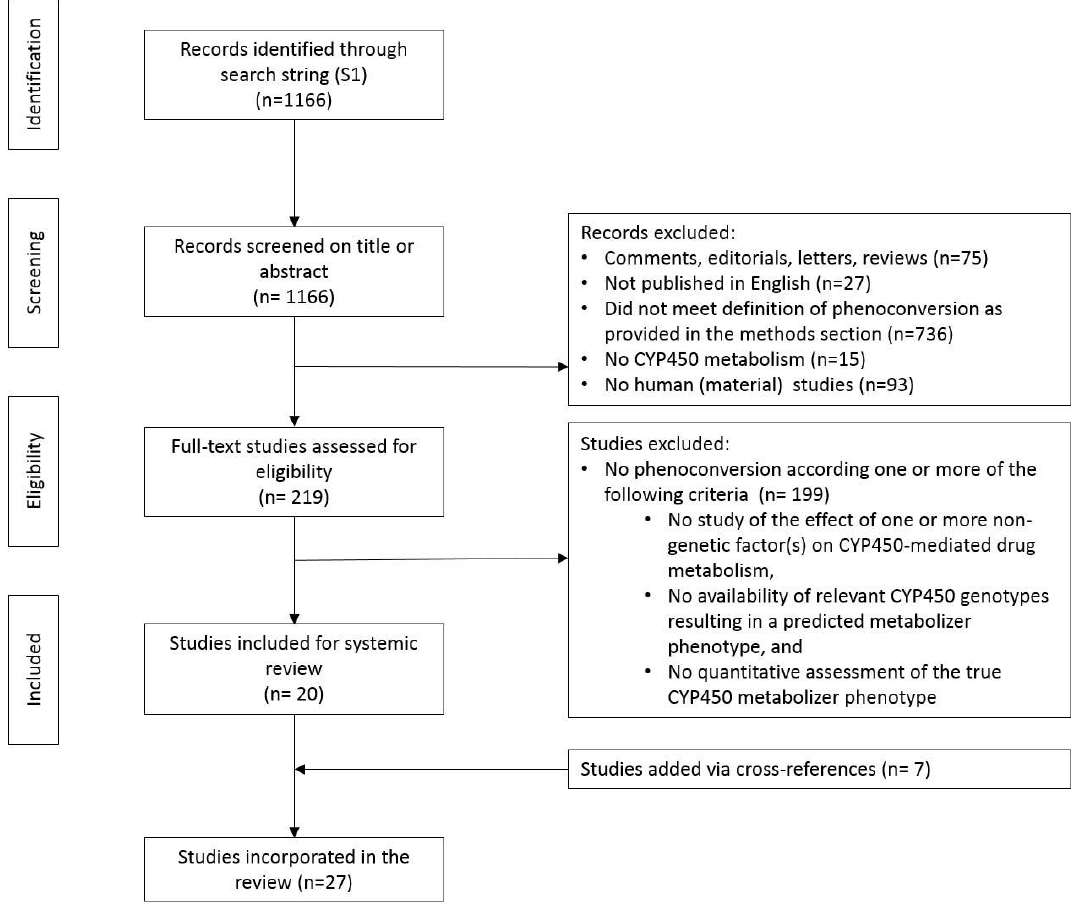
Figure 1. S tudy flow diagram of the retrieval and review process (Appendix A). Figure 1. Study flow diagram of the retrieval and review process (Appendix